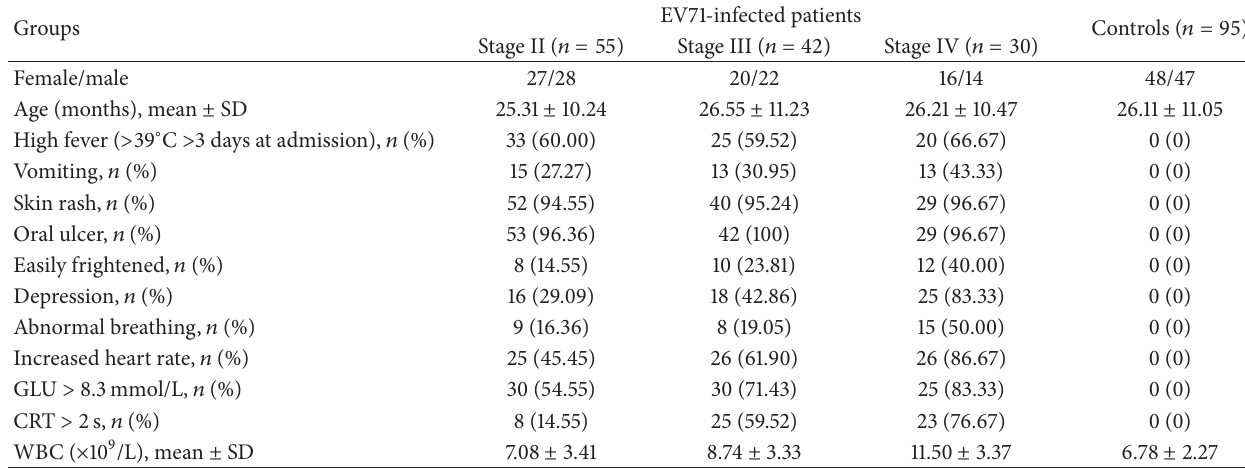
Table 1: Summary of clinical